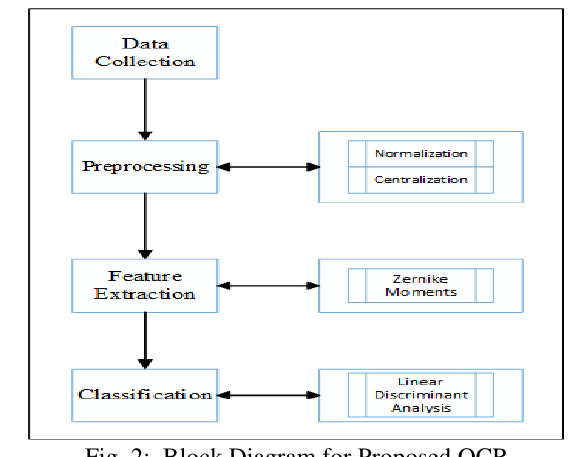
Fig. 2: Block Diagram for Proposed